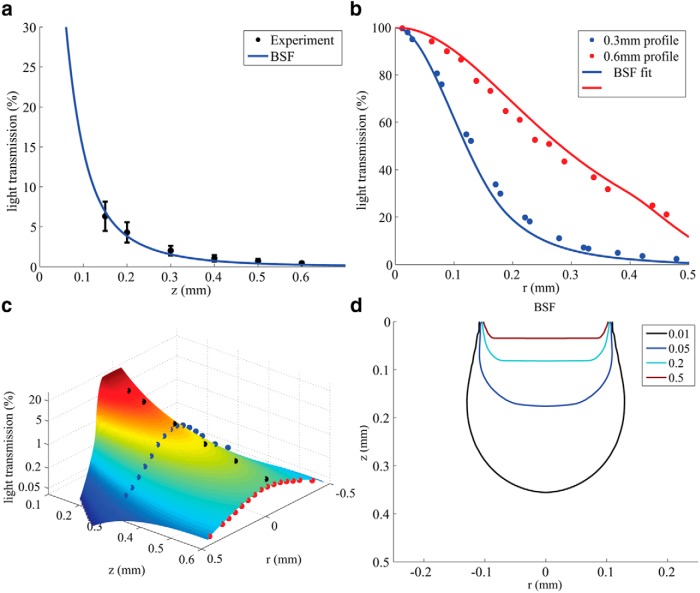
Experimental results: light transmission in a mouse cortex along the z-axis (a) and the radial axis (b) at 300 μm (blue) and 600 μm (red). The solid lines are the best fit of the BSF model. c, Surface plot of the simulated light distribution in the slice, obtained with BSF model using the experimentally estimated parameters (µs = 211 cm−1, g = 0.86), with overlaid experimental measurements (colors matched to a and b). Light transmission is in log scale. d, Contour map of the simulated light distribution.